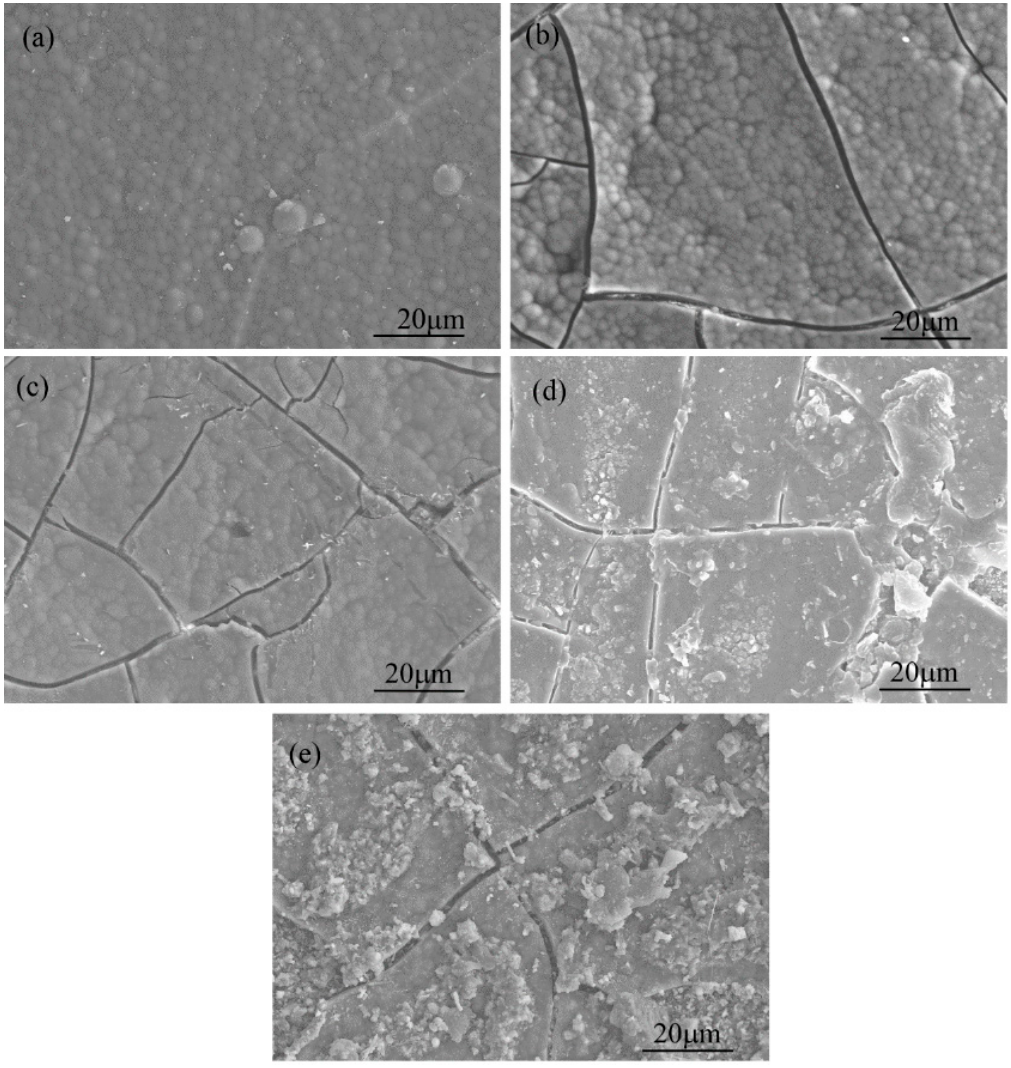
Figure 2. The surface morphology of as-received ( a ) and annealed SiBCN-Si 3 N 4 ceramics at different temperatures: ( b ) HT-14; ( c ) HT-15; ( d ) HT-16; and ( e ) HT-17.